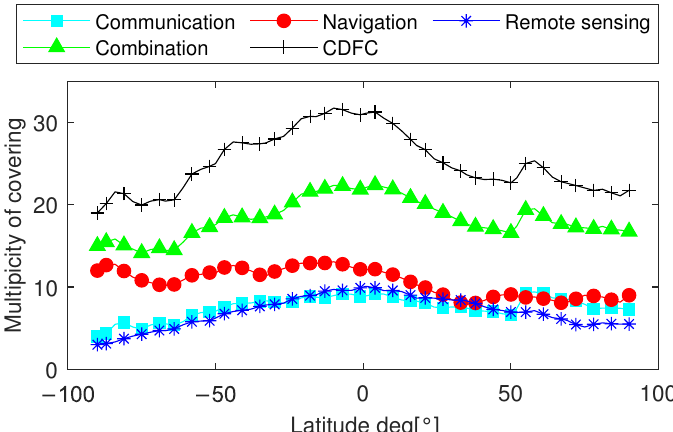
Figure 5. Constellation coverage map.